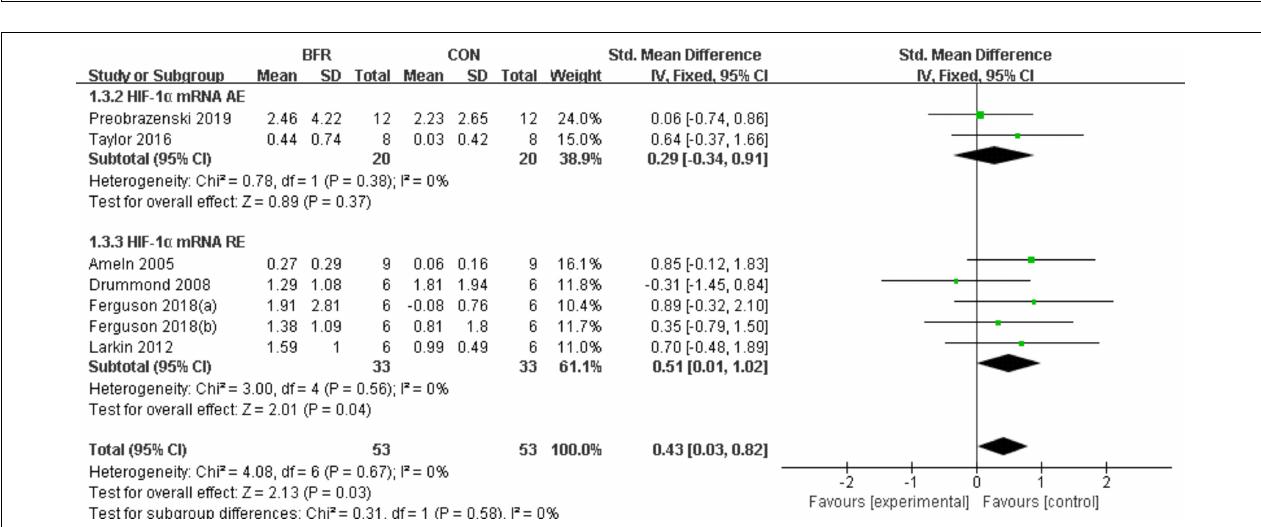
FIGURE 2 | The forest plot of the effect size for studies assessing the effect of blood flow restriction exercise on the VEGF (A) and VEGFR-2 (B) mRNA.